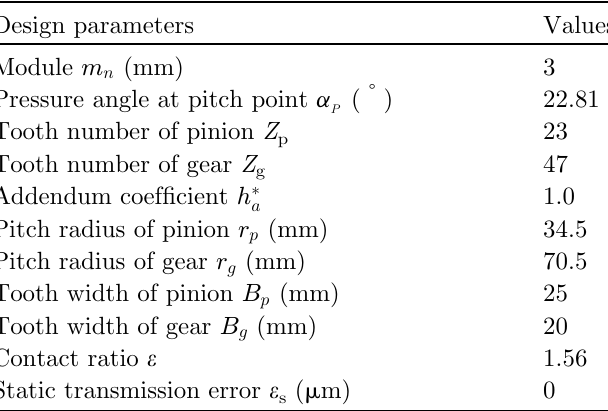
Table 1. Design parameters for CRC gear drive.